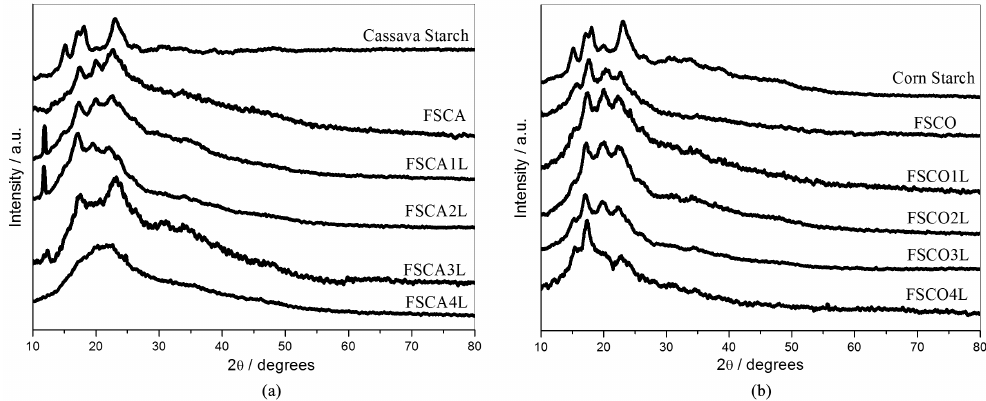
Figure 2. XRD diffractograms of the films of cassava (a) and corn (b) starch. Table 1. Elasticity modulus values, maximum stress, specific deformation and crystallinity index for the films.